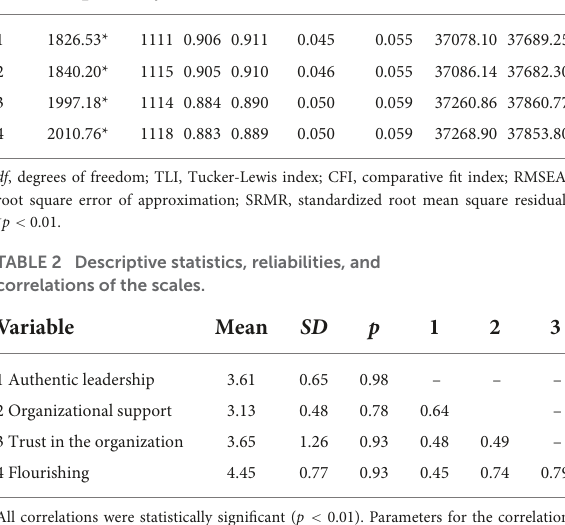
TABLE 1 Fit statistics for the competing measurement models.